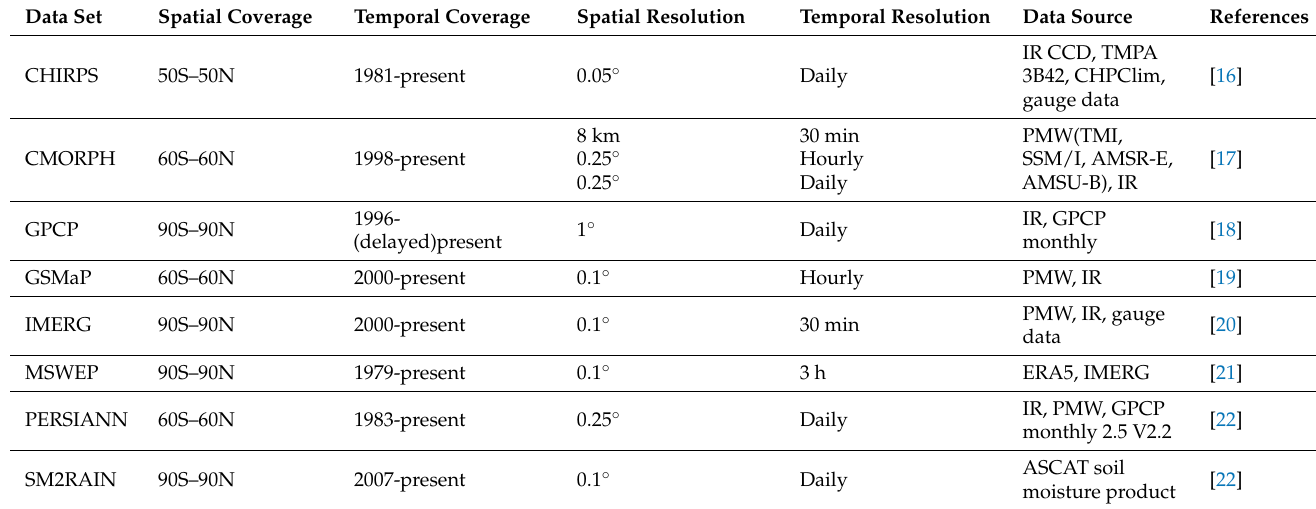
Table 1. Information about the eight SPPs in this